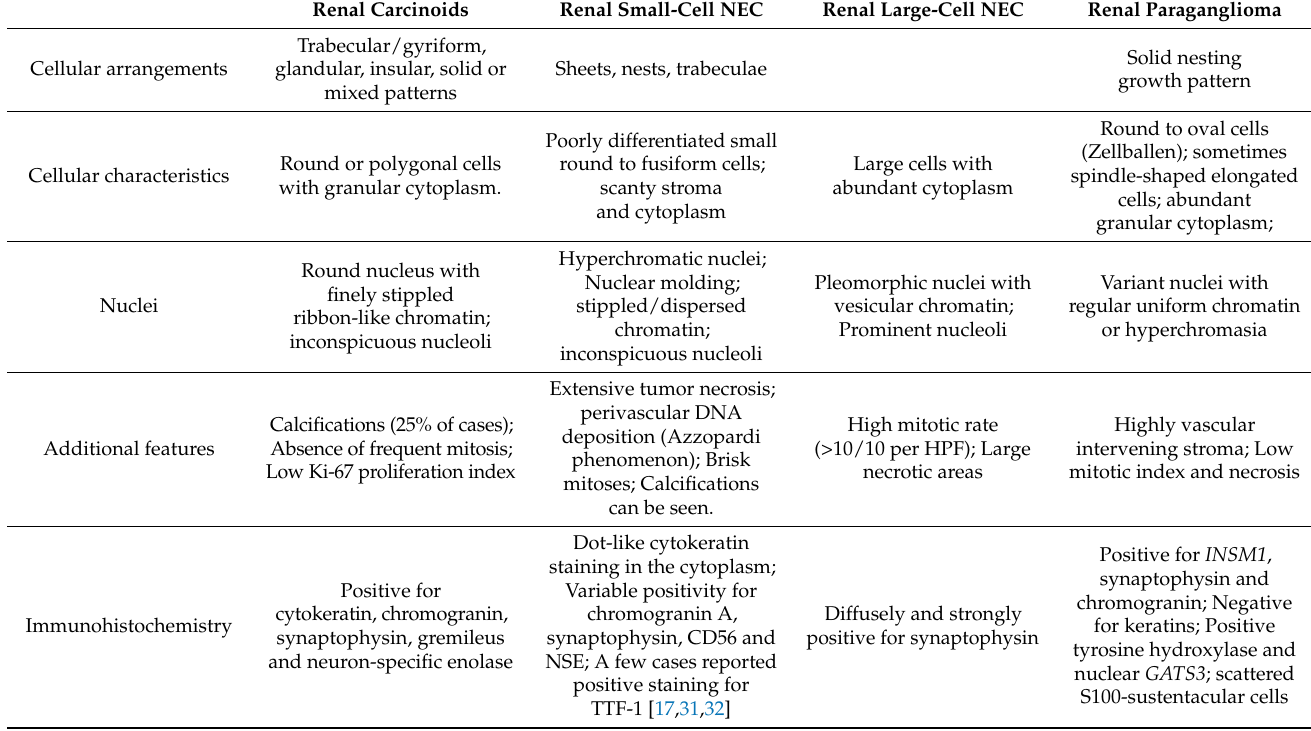
Table 1. Morphological characteristics of renal NENs